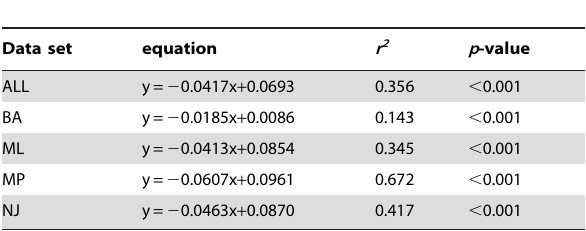
Table 1. Regression analyses for different tree-building methods applied to 100 combinations of a set of outgroup and ingroup taxa.